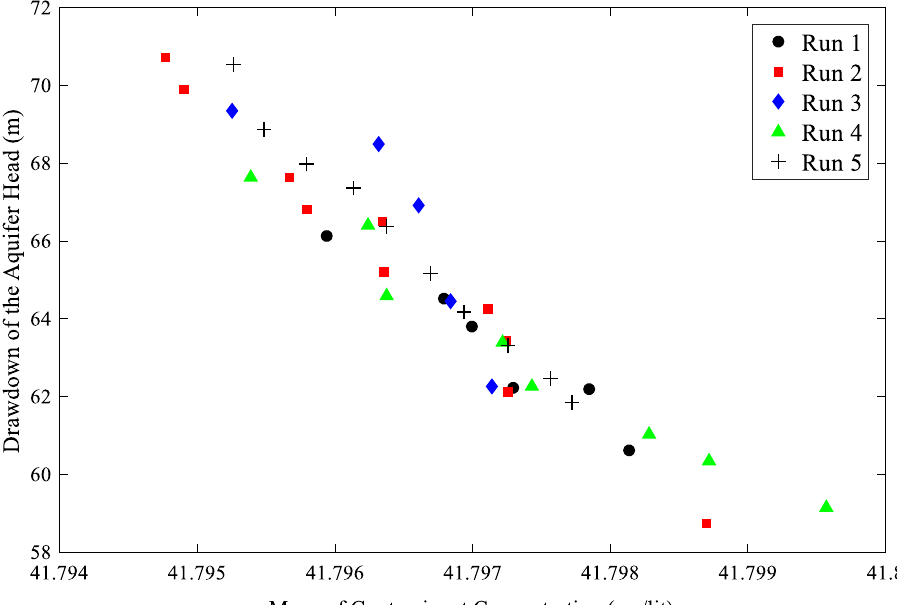
Fig. 8 Comparison of the Pareto fronts in 5 runs of NSGA-II algorithm